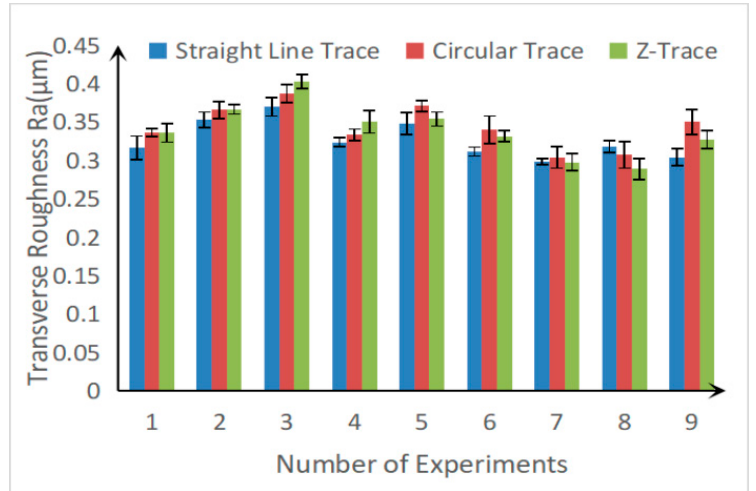
Figure 12. Comparison of lateral Ra values in the three different grinding tracks.